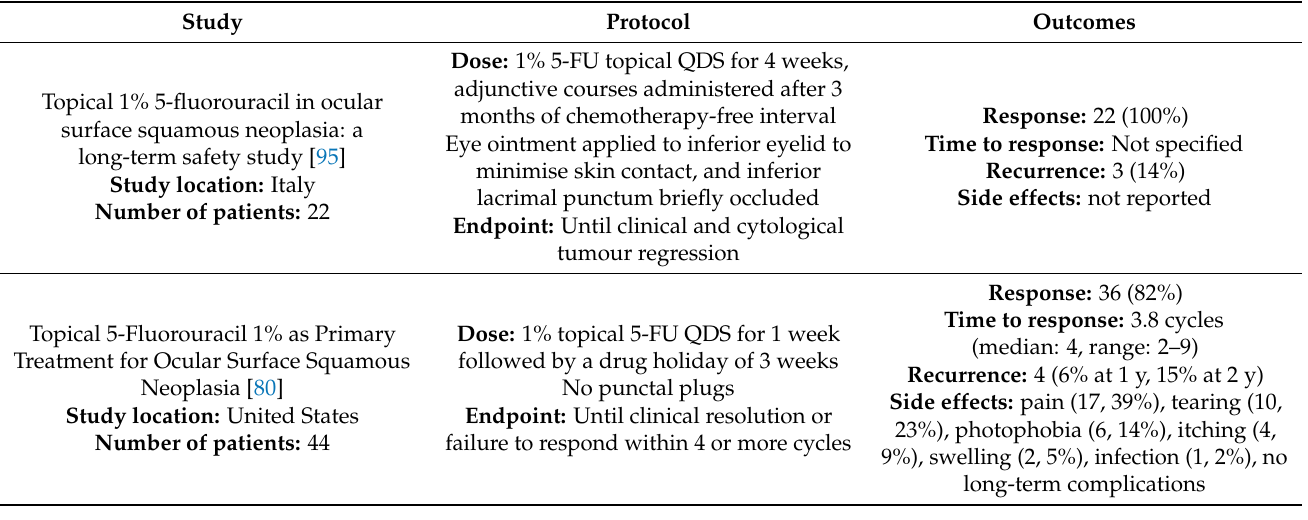
Table 1. Summary of study protocols using 5-Fluorouracil (5-FU) as sole treatment of ocular surface squamous neoplasia